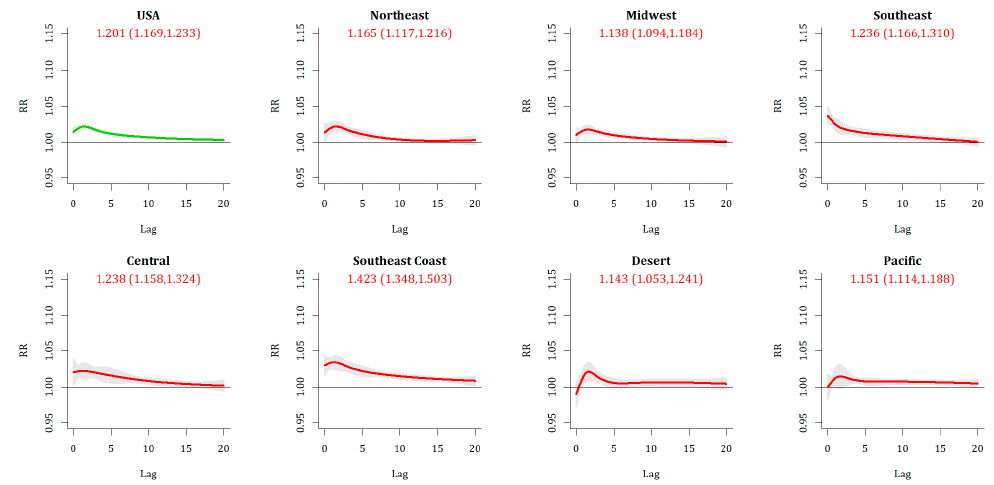
Figure 2. Relative risk (and confidence interval) associated with ECE day, for US as a whole (upper left) and each of the seven regions.